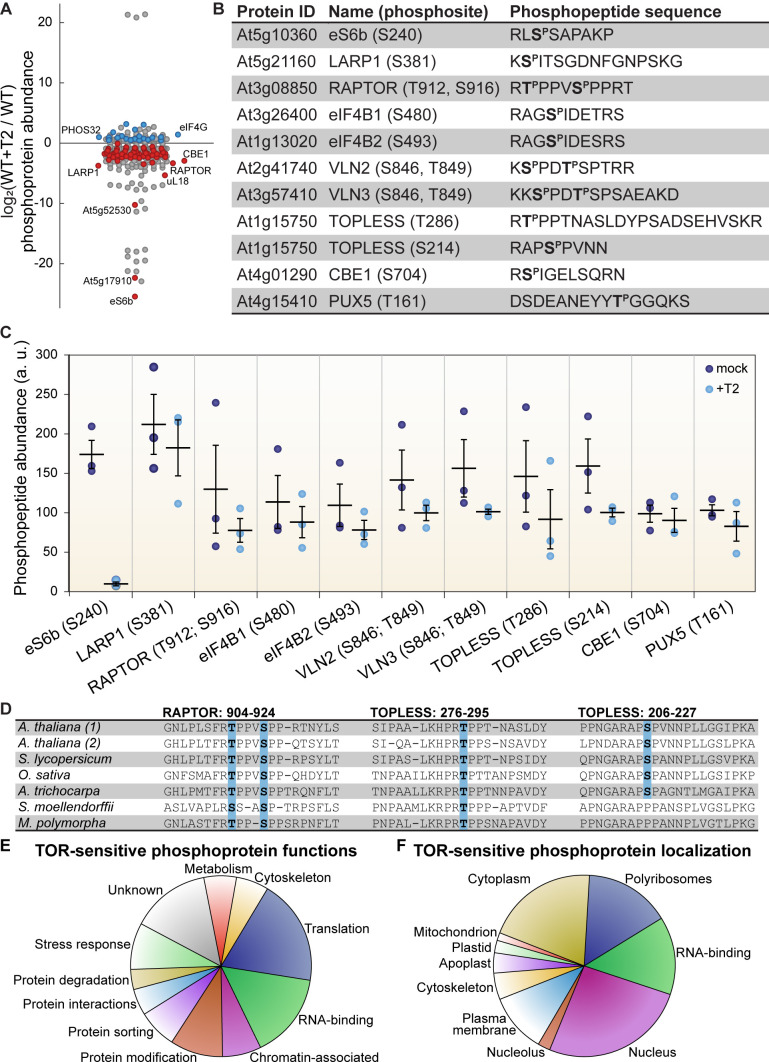
TOR regulates the phosphorylation of critical proteins involved in translation, cellular dynamics, and signal transduction in Arabidopsis seedlings.(A) Phosphoprotein levels decreased for the majority (80%) of the 85 proteins that were significantly differentially phosphorylated after Torin2 treatment. The scatterplot displays the difference in phosphoprotein abundance in Torin2-treated seedlings for every detected phosphoprotein. Statistically-significant differences are indicated by colored dots (red for decreased abundance, blue for increased abundance; p<0.05, Mann–Whitney U test). (B) The protein ID, name, phosphosite(s), and the sequence of individual detected phosphopeptides from select proteins are shown. (C) The abundance of phosphopeptides shown in (B) in response to Torin2 are represented by dots in this scatterplot (mock-treated, dark blue; Torin2-treated, light blue). Black lines represent the mean and standard error. In each case, the difference was statistically-significant (p<0.05, t test). (D) Alignment of RAPTOR and TOPLESS protein sequences surrounding the phosphosites that were sensitive to Torin2 treatment. A. thaliana (1) shows RAPTOR1 and TOPLESS sequences; A. thaliana (2) shows the sequences of their closely-related paralogs, RAPTOR2 and TOPLESS-RELATED 1. Sequences from representative land plant species are shown in phylogenetic order: A. thaliana (thale cress, a rosid) Solanum lycopersicum (tomato, an asterid), Oryza sativa (rice, a monocot), Amborella trichocarpa (representing a basal lineage of angiosperms), Selaginella moellendorffii (spikemoss, a lycophyte), and Marchantia polymorph (common liverwort, representing a basal lineage of land plants). Phosphosites are highlighted in blue. (E) Categorical analysis of the molecular functions of Torin2-sensitive phosphoproteins is shown. (F) Categorical analysis of the subcellular localization of Torin2-sensitive phosphoproteins is shown.